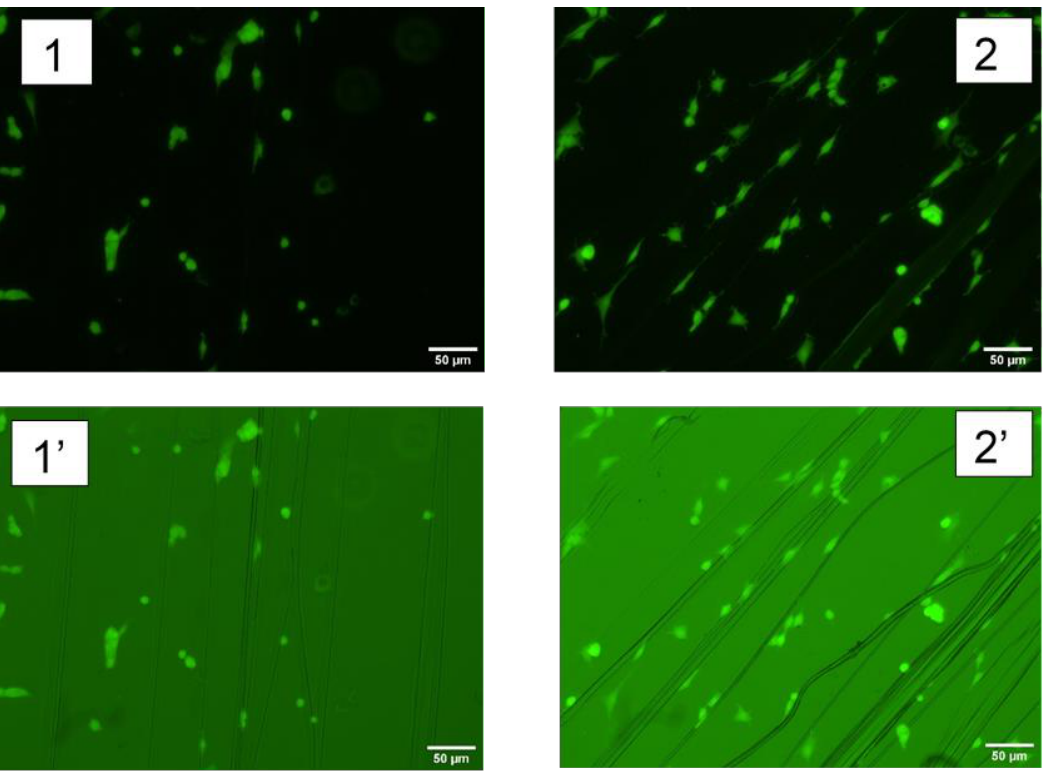
Figure 6. MSC cells cultured in the presence of regenerated silk fibers. Non-functionalized fibers, ( 1 ) fluorescent micrograph, and ( 1′ ) bright field micrograph. RGD-functionalized fibers, ( 2 ) fluores- cence micrograph, and ( 2′ ) bright field micrograph. Table 6. Comparison of the number of MSCs attached to the control and RGD-functionalized fibers after 24 h of cell culturing. The cells are counted from micrographs with the same scale as those shown in Figure 6.